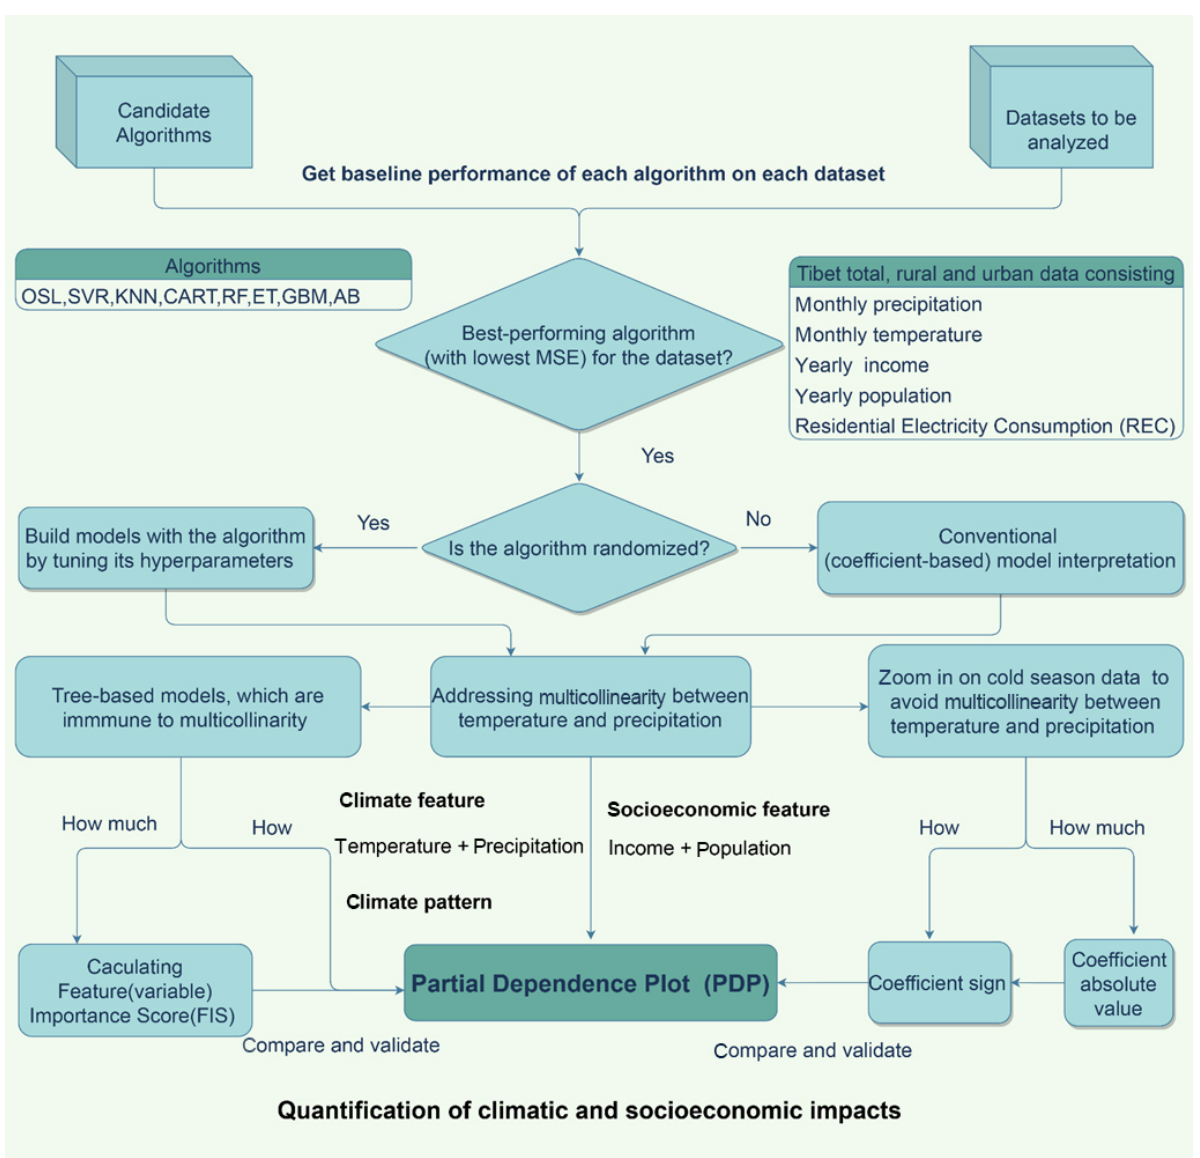
Figure 1. Research design.